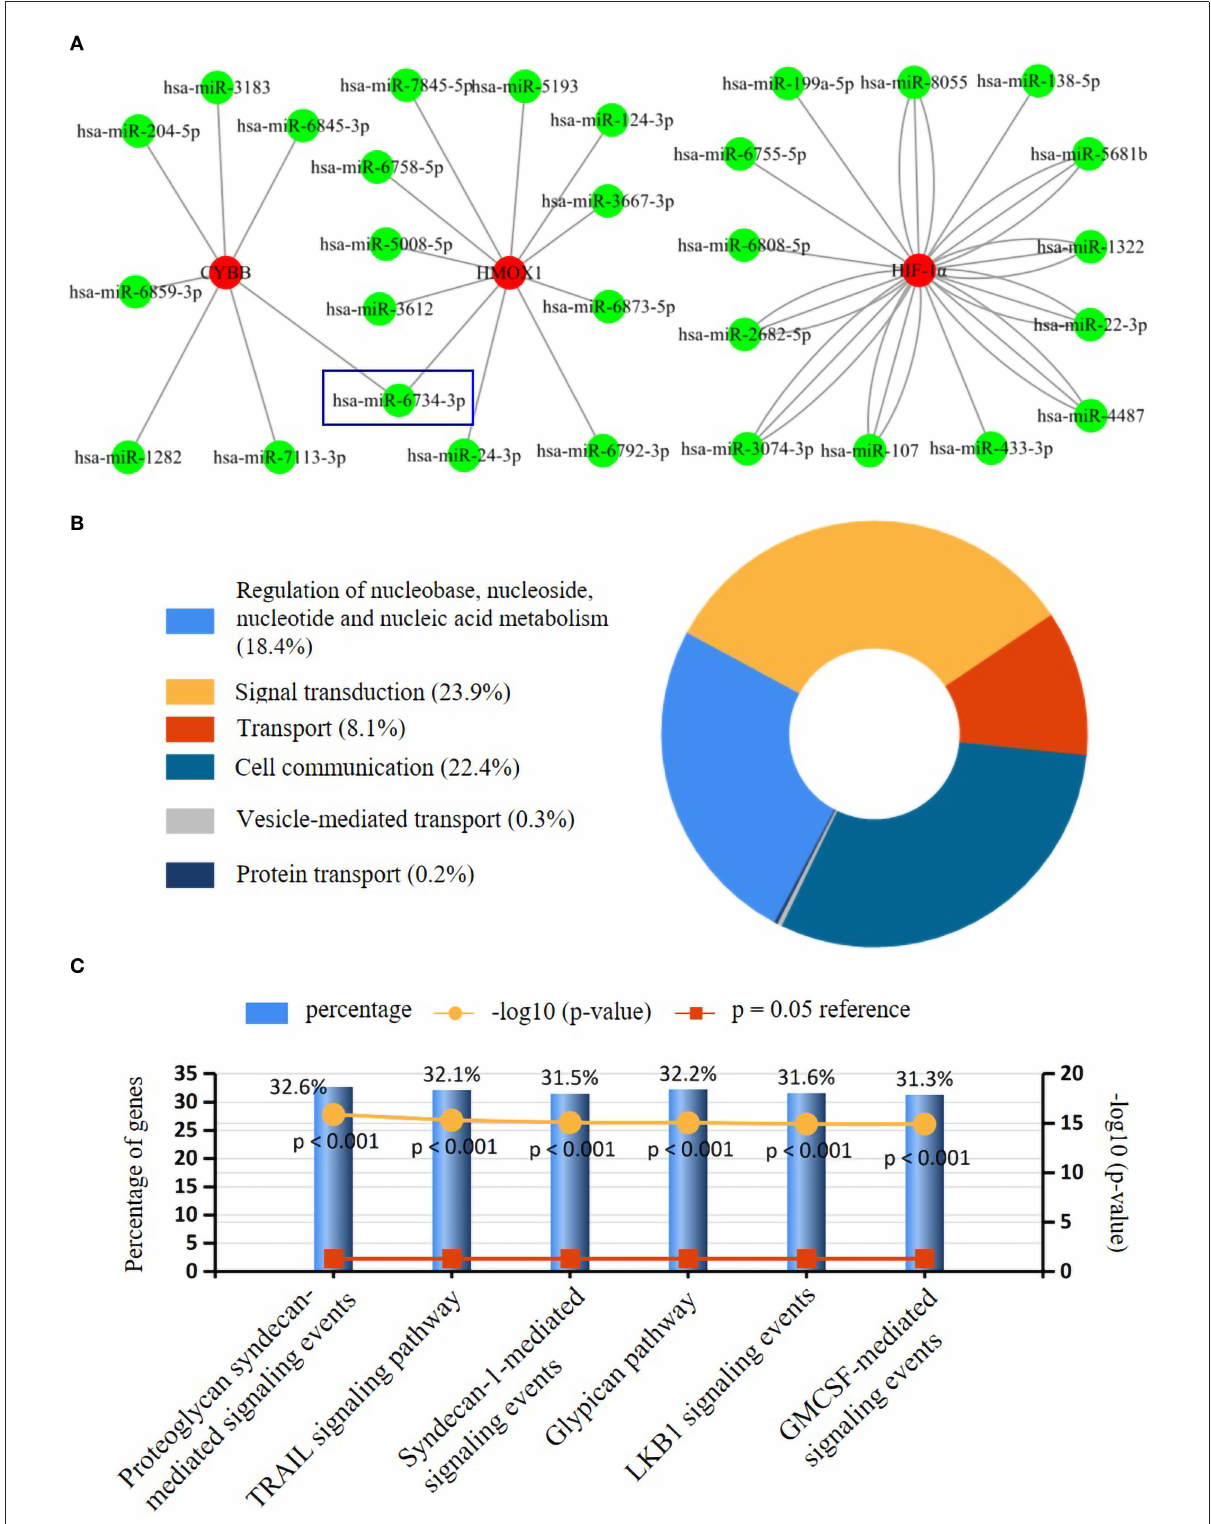
FIGURE5 Interaction networks between key ferroptosis DEGs and their targeted miRNAs. (A) Interaction network between genes of the key ferroptosis DEGs and its targeted miRNAs. Genes were colored in red, and miRNAs were colored in green. Only has-miR-6743-3p with higher amounts of cross-linked genes ( = 2, HMOX1, and CYBB) was shown in the blue wireframe. (B) The molecular function of key ferroptosis DEGs-related miRNAs. (C) The top three biological pathways (Proteoglycan syndecan mediated-signaling events, TRAIL signaling pathway, and glypican pathway) enriched of the key ferroptosis DEGs-related